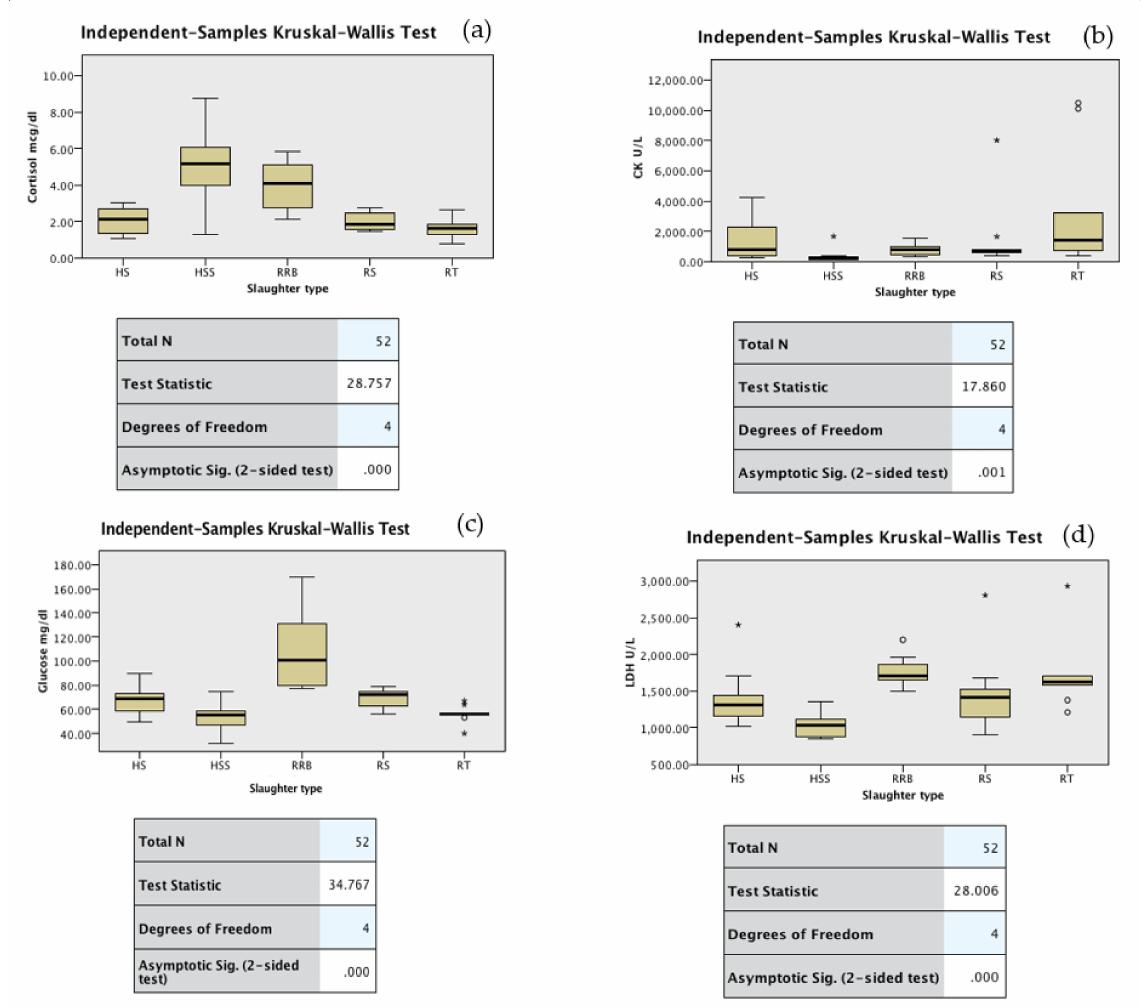
Figure 2. Box and whisker plots for cortisol ( a ), CK ( b ), glucose ( c ), and LDH ( d ) levels comparing halal slaughter (HS), halal stunning slaughter (HSS), rotating restraint box (RRB), regular slaughter (RS) and resting (RT). In the boxplot, the thicker line in the middle is the median value. The top and bottom box lines show the first and third quartiles. The whiskers show the maximum and minimum values, except for the outliers (circles) and extremes (asterisks).